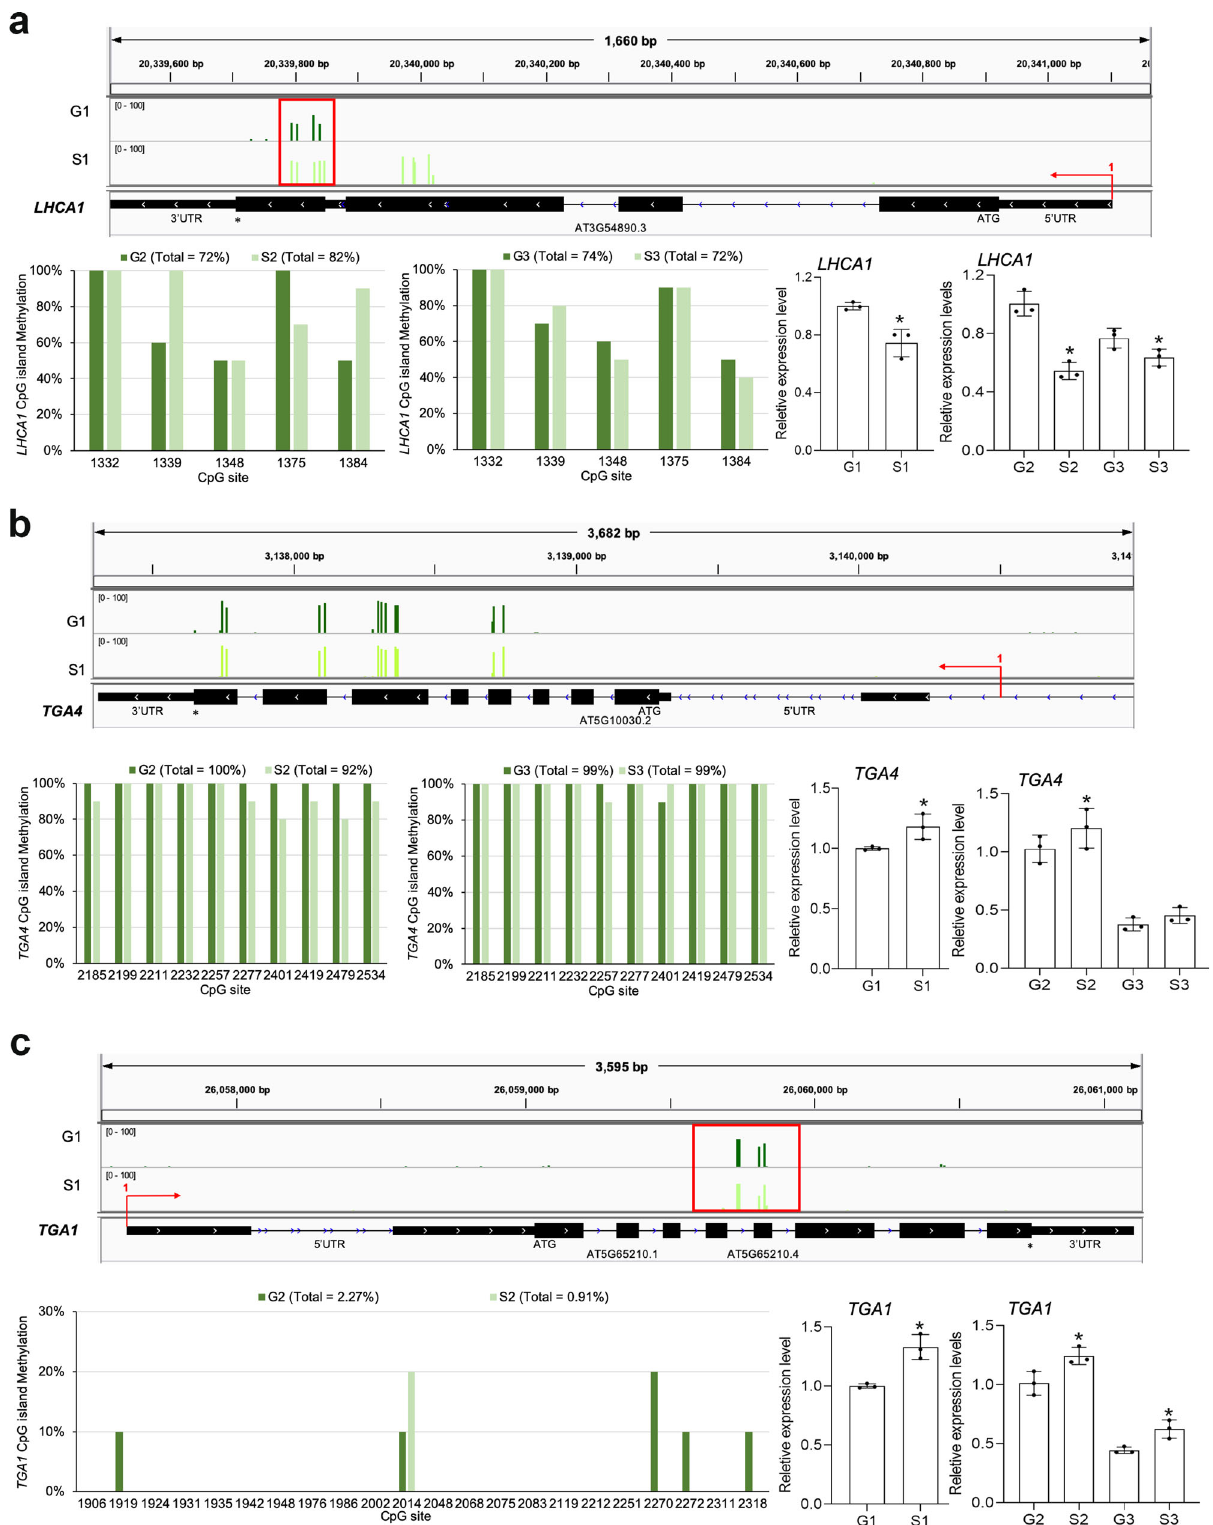
Fig. 8 Isolation and veri fi cation of the space fl ight-induced heritable DMRs and analysis of the gene expression levels in the offspring. Visualization and BSP (Bisul fi te-Sequencing PCR) analysis of selected putative space fl ight-induced heritable DMRs and expression levels of a LHCA1 , b TGA4 , and c TGA1 in the offspring of space fl ight and ground control plants. Visualization of methylation data was performed, using the Integrated Genome Viewer (IGV) (http://software.roadinstitute.org/software/igv). The inherited methylation level of CpG islands was veri fi ed by using BSP analysis. The error bar is the standard deviation. An asterisk * indicates a statistically signi fi cant difference between the space fl ight and control samples using Student ’ s two-tailed t -test ( p <